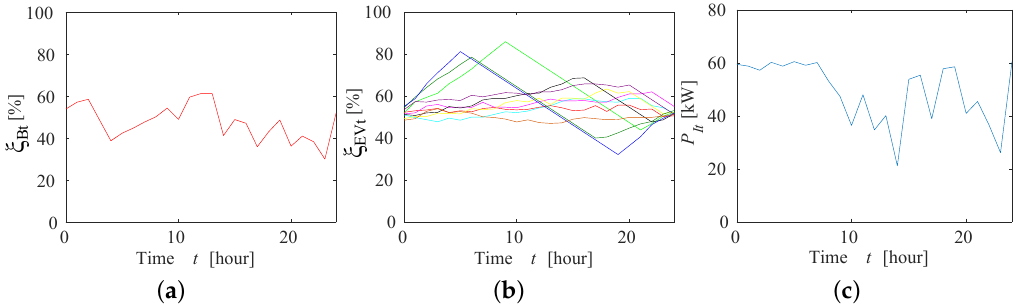
Figure 13. Pareto solution for reduced PV power output.